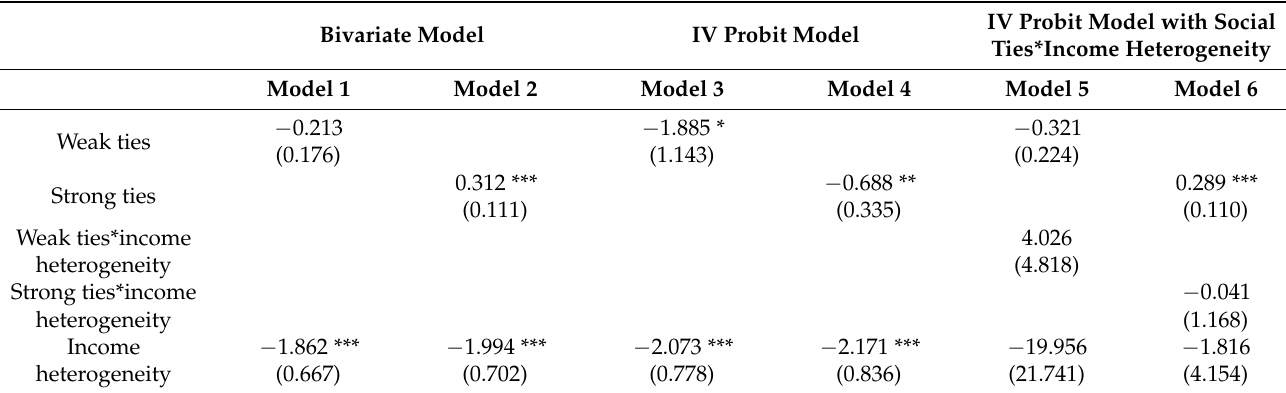
Table 2. Estimation results of farmer’s attitude–behavior